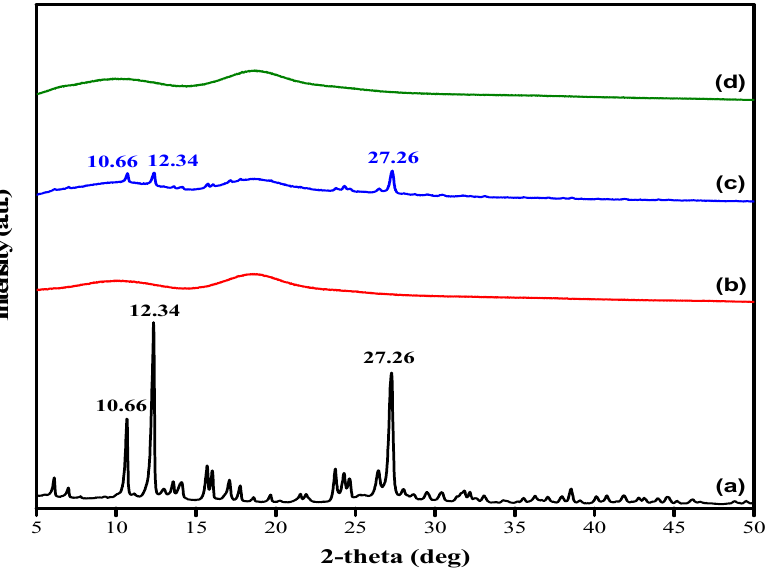
Figure 2. XRD patterns of ( a ) quercetin, ( b ) HP- β -CD, ( c ) quercetin/HP- β -CD physical mixture, and β -CD inclusion ( d ) quercetin/HP- β -CD inclusion complex. ( d ) quercetin/HP-